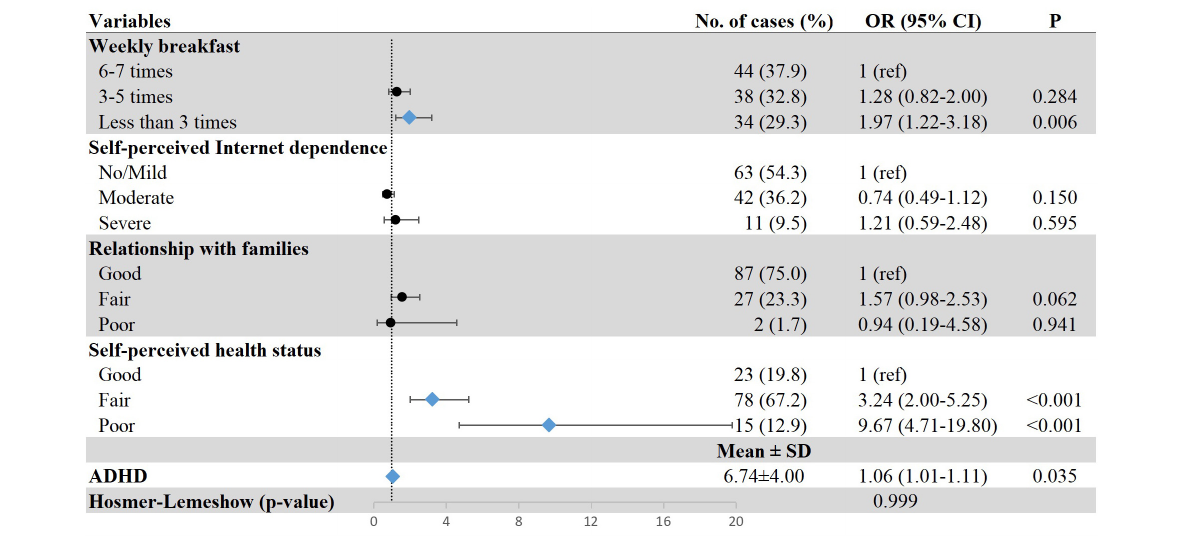
FIGURE4 Associations between demographic and clinical characteristics and EMA. Row with blue diamond indicates statistical significance. ADHD, attention-deficit/hyperactivity disorder; EMA, early-morning awakening with inability to return to sleep; OR, odds ratio; 95% CI, 95% confidence